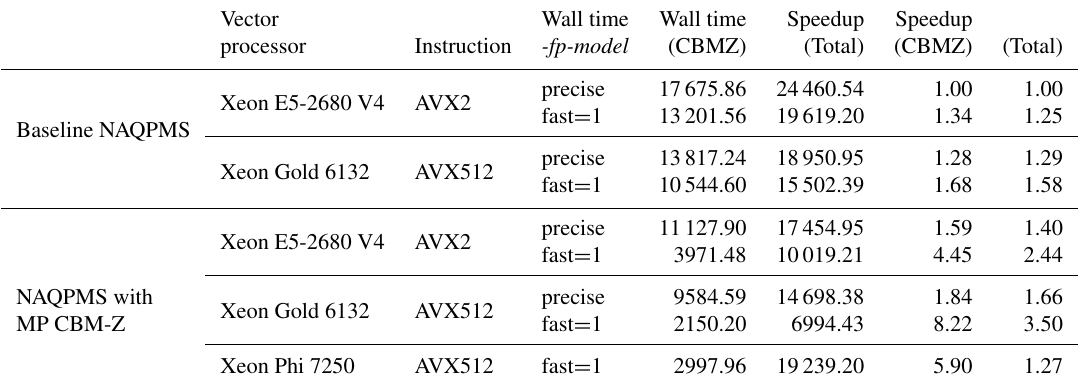
Table 6. The performance tests of the baseline and optimized code on the diverse platforms with different compile flags. The unit of the wall times for the tests is seconds